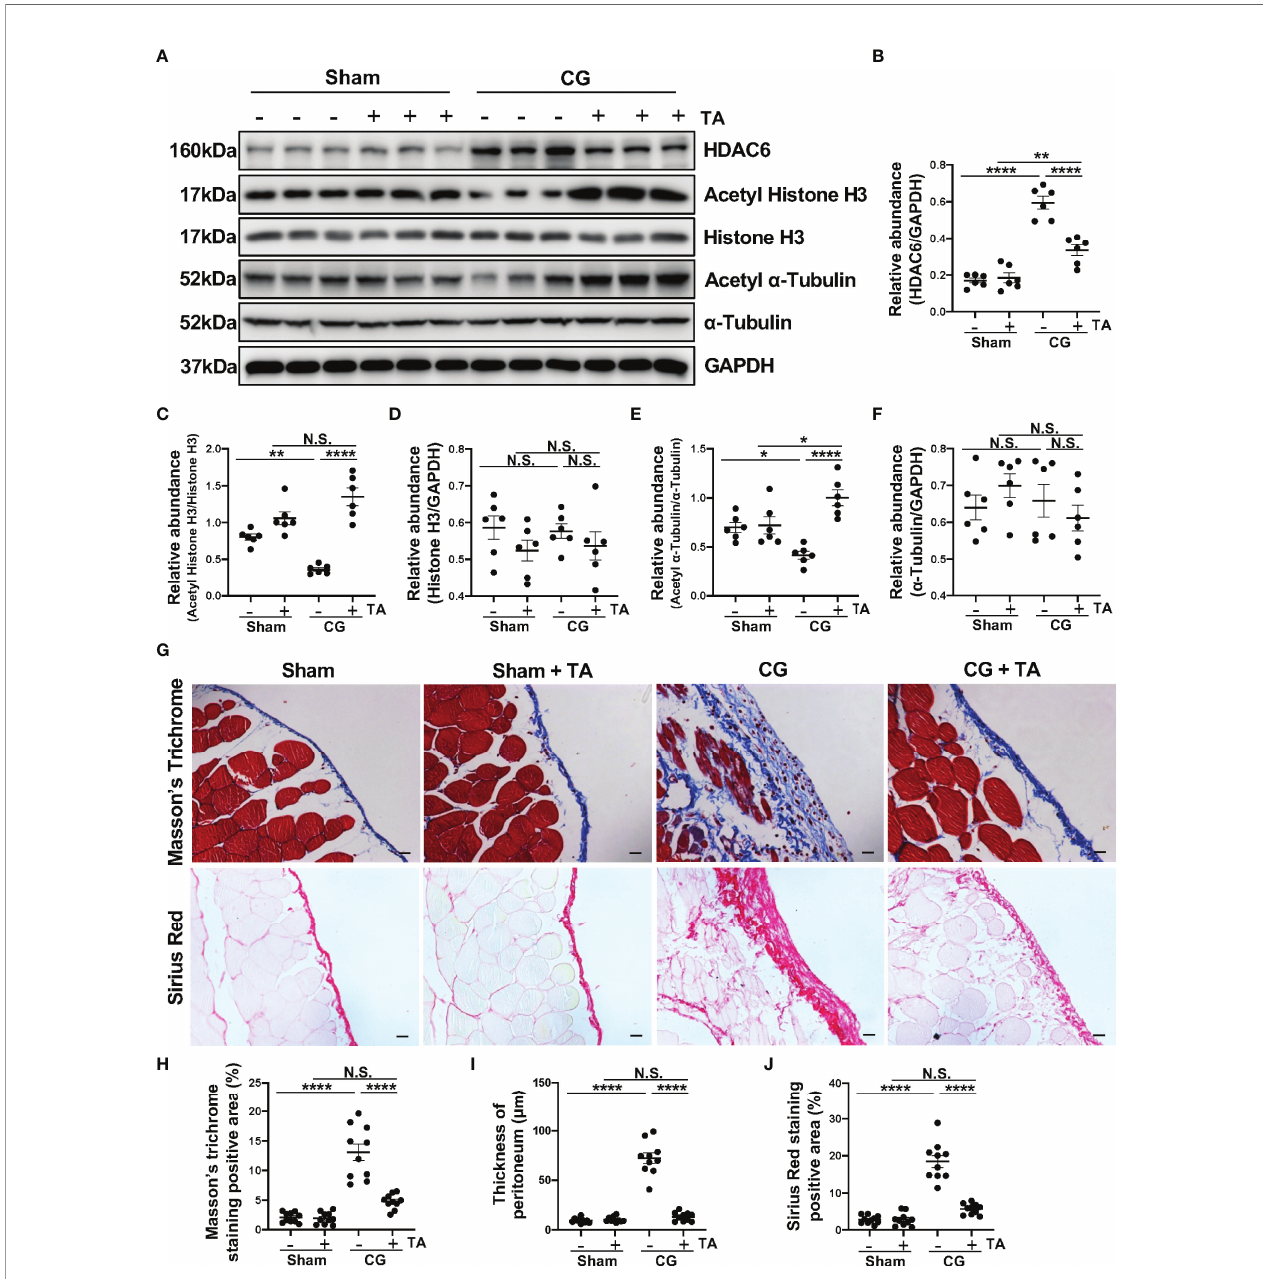
FIGURE 1 | TA effectively suppresses HDAC6 expression and CG-induced peritoneal fi brosis. (A) Western blot analysis showed the protein levels of HDAC6, Acetyl Histone H3, Histone H3, Acetyl a -Tubulin, a -Tubulin, and GAPDH in peritoneum from different groups of mice. Expression levels of (B) HDAC6, (C) Acetyl Histone H3, (D) Histone H3, (E) Acetyl a -Tubulin, and (F) a -Tubulin in different groups were quanti fi ed by densitometry and normalized with GAPDH, Histone H3, and a -Tubulin respectively. (G) Representative micrographs of Masson ’ s Trichrome staining and Sirius Red staining of the peritoneum from different groups of mice. (H) The positive area of Masson ’ s Trichrome staining-positive submesothelial area (blue). (I) The thickness of peritoneum according to Masson ’ s Trichrome staining. (J) The positive area of Sirius Red-positive submesothelial area (red). Data were expressed as means ± SEM. *P<0.05, **P<0.01, ****P<0.0001. All scale bars = 20 m m. NS: P ≥